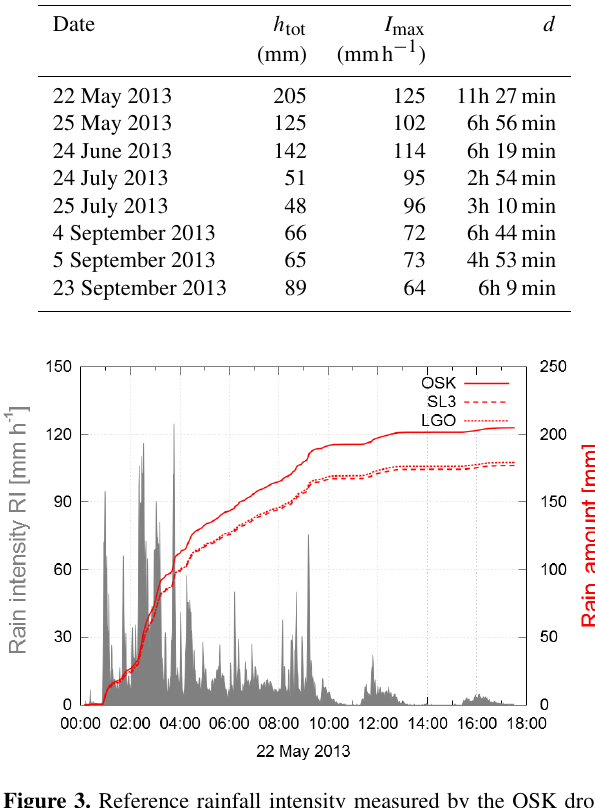
for the OSK (solid red line) and the SL3 and LGO gauges (dashed and dotted line). The underestimation of the cumu- lative rain depth by the two TBRGs is evident from Fig. 3. The relative underestimation of the total depth, for this par- ticular event, is equal to 13.6 and 12.5 % for the SL3 and LGO rain gauges